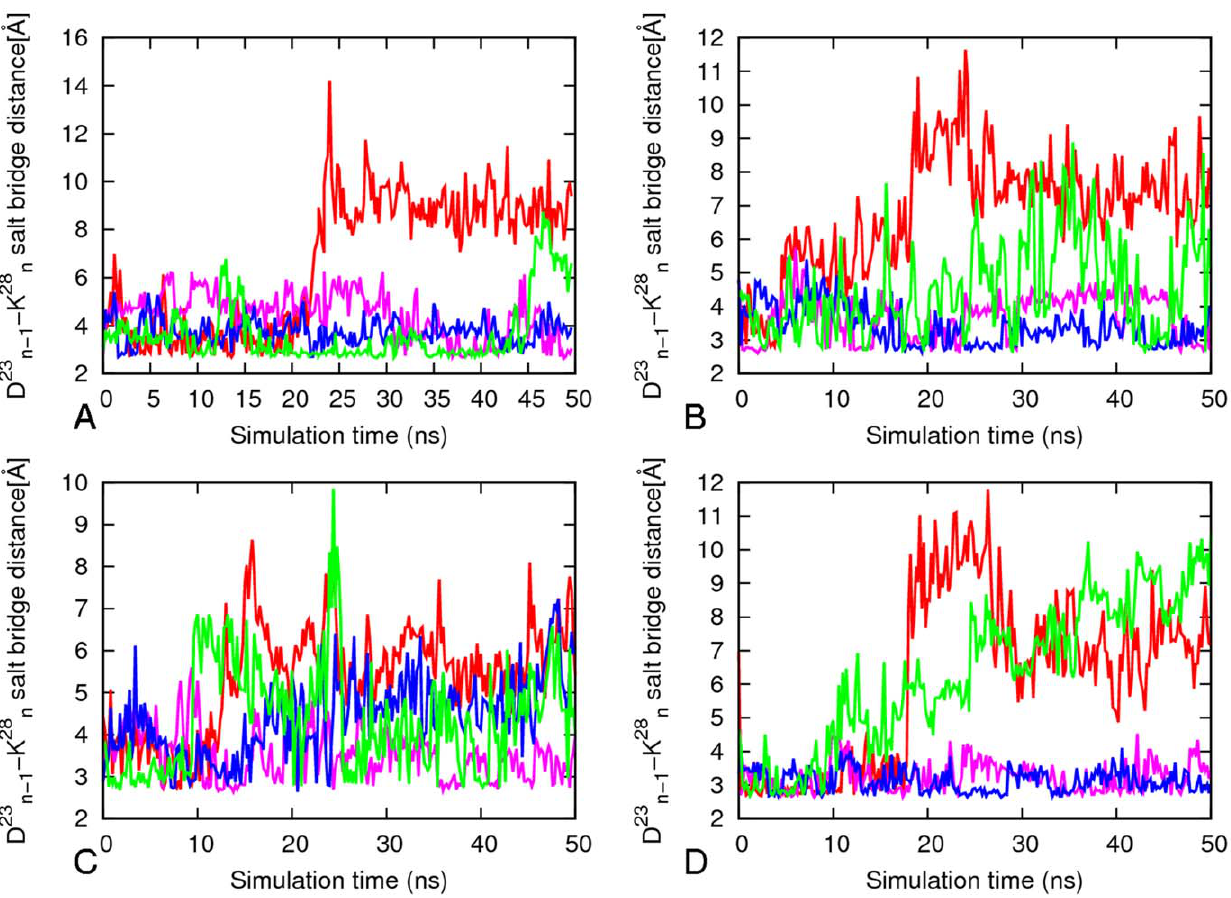
Figure 7. Average inter-chain salt–bridges (Asp n23 /Lys n 2 123 ) along simulation for 16–21P, 27–32, 30–40 and 35–42. The results are the average of two independent simulations and it is the average of the two layers of each system. A) 1621P B) 27–32 C) 35–42 and D) 30–30. Red, 23 - 28 ; pink, 23 - 28 ; blue, 23 - 28 ; green 23 - 28 . 1 D 2 K 2 D 3 K 3 D 4 K , 4 D 5 K